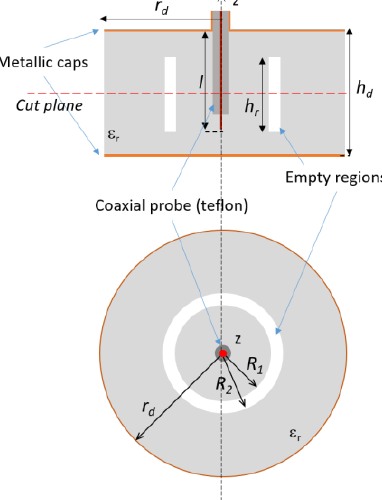
Figure 4. Lateral and top view of the second iteration of the design process in which an empty annular sector is introduced.